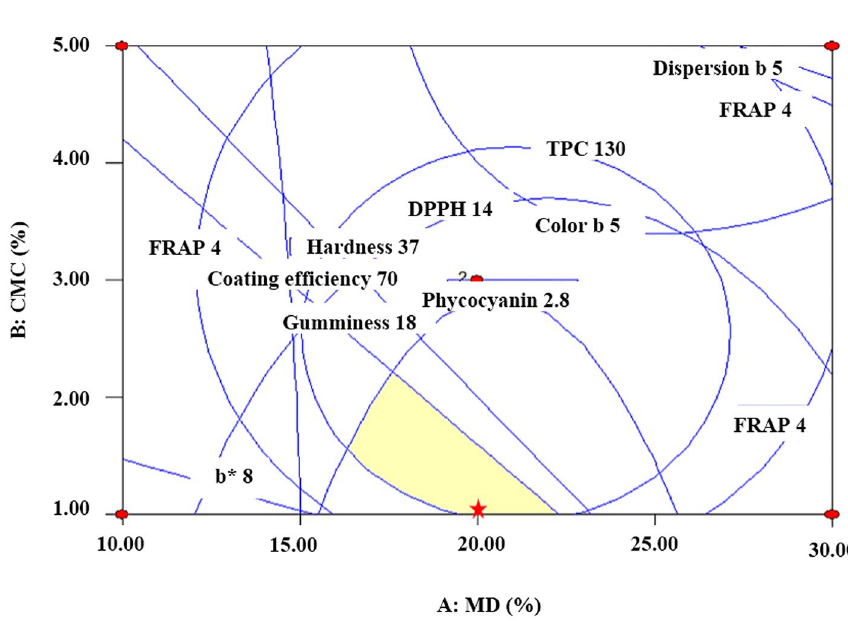
Figure 3. Overlay plot for the optimal concentration for edible coating instant rice with S. platensis